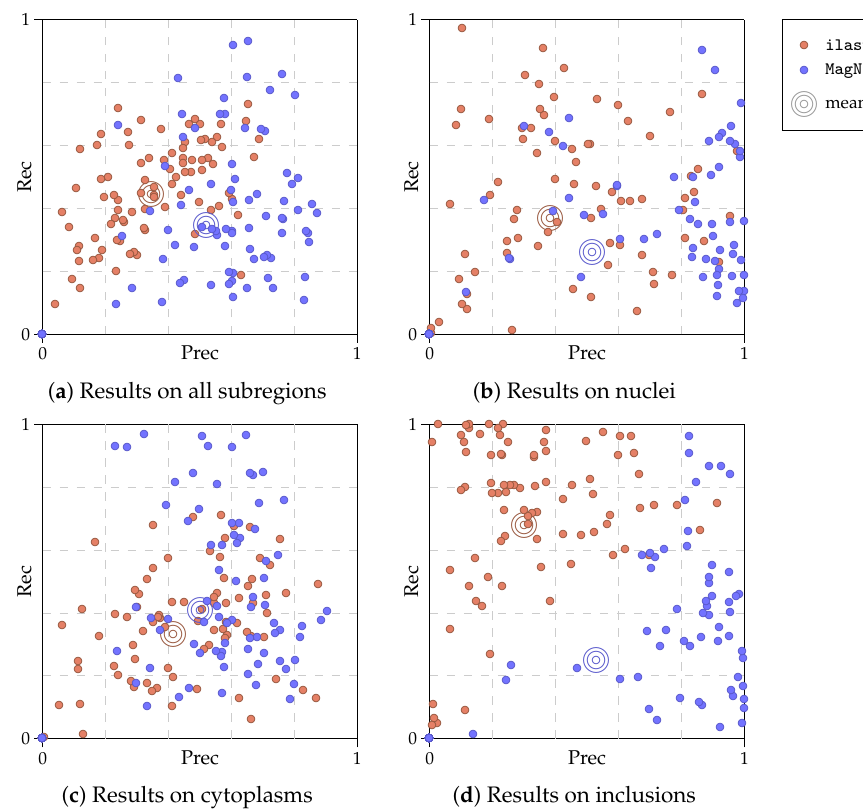
Figure 8. Distribution of results for ilastik and MagNoLia according to the type of subregion. Plot ( a ) represents the Prec and Rec for all subregions, while Plots ( b – d ) represent the precision and recall of each subregion of an MN. The concentric circles represent, for each plot, the mean (centre of mass) of the point